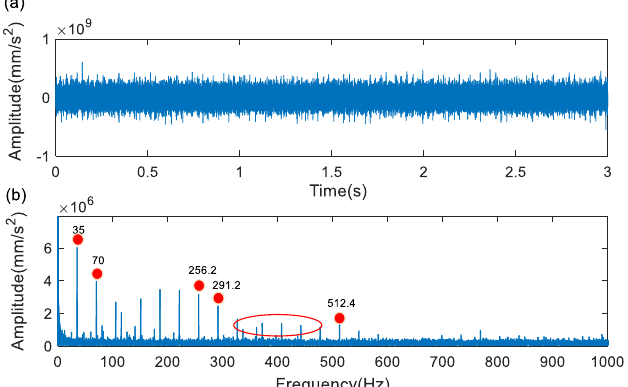
Figure 10. Results of inner ring fault using FEM-base wavelet basis: ( a ) filtered signal; ( b ) envelope spectrum of the filtered signal.